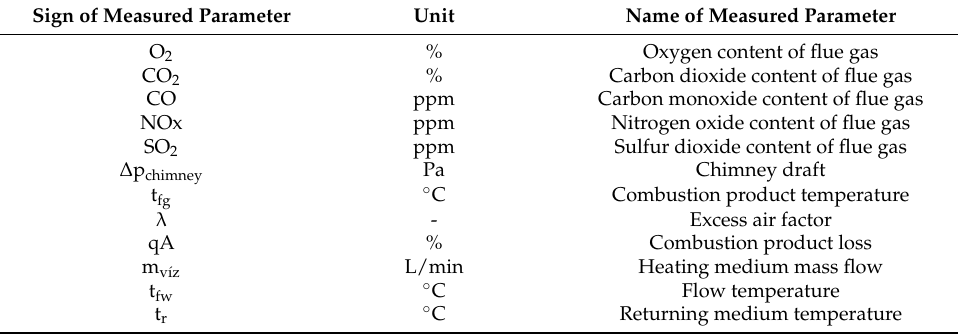
Figure 2. Geometrical parameterization of draft control door (*: multiplication). Table 2. Measured parameters.